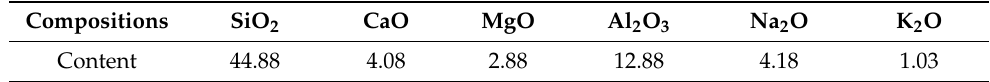
Table 2. Chemical compositions of bentonite (mass/%).